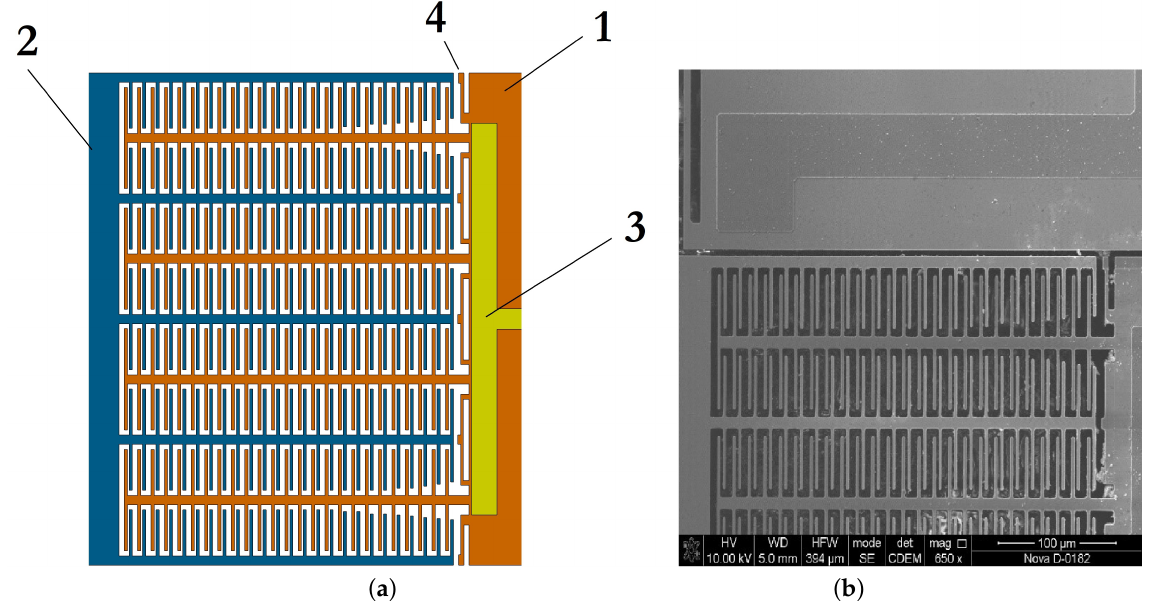
Figure 6. Capacitive displacement converter: ( a ) schematic view, stator ( 1 ), rotor ( 2 ), contact pad ( 3 ), elastic locking elements ( 4 ); ( b ) SEM